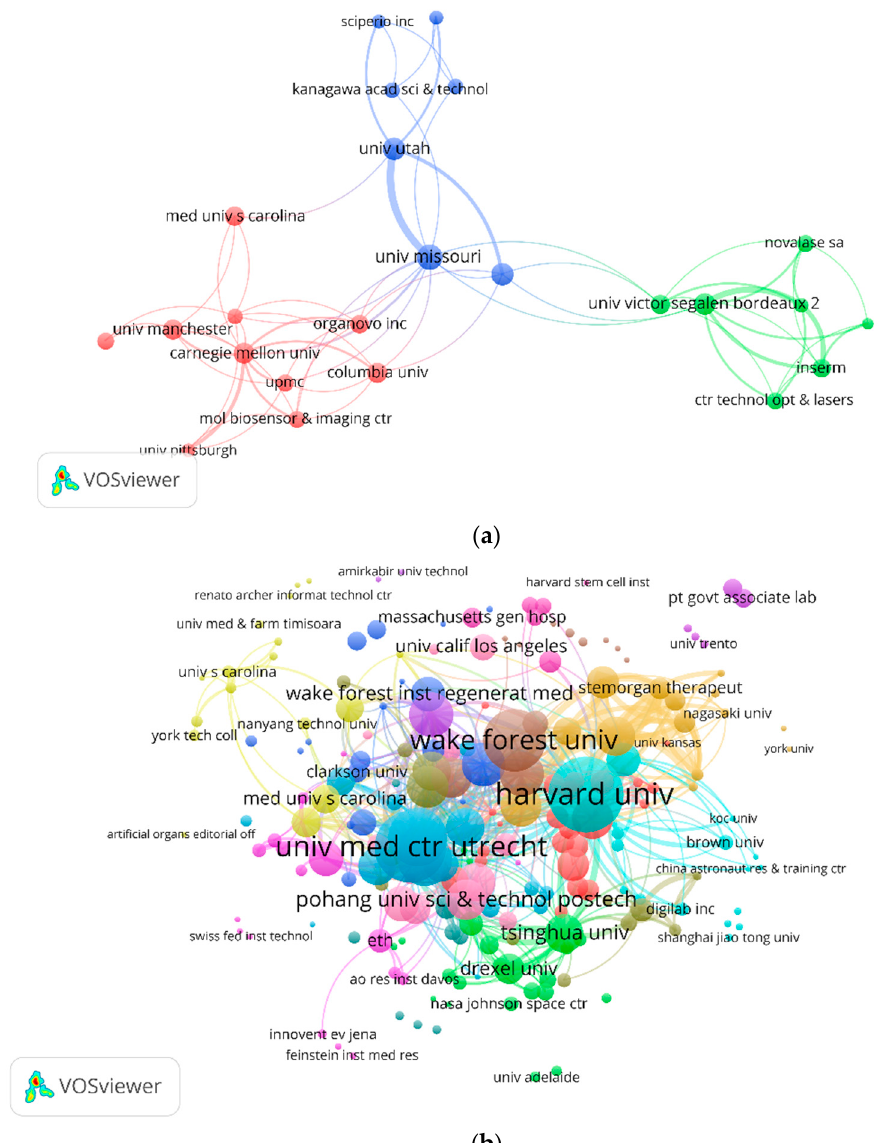
Figure 5. Temporal evolution of the involved organizations. Citation analysis of the organizations between 2006 and 2016 with a time interval of 5 years, ( a ): 2006–2010; ( b ): 2011–2015. The size of each node is proportionate to its degree and the thickness of the links represents the tie strength.